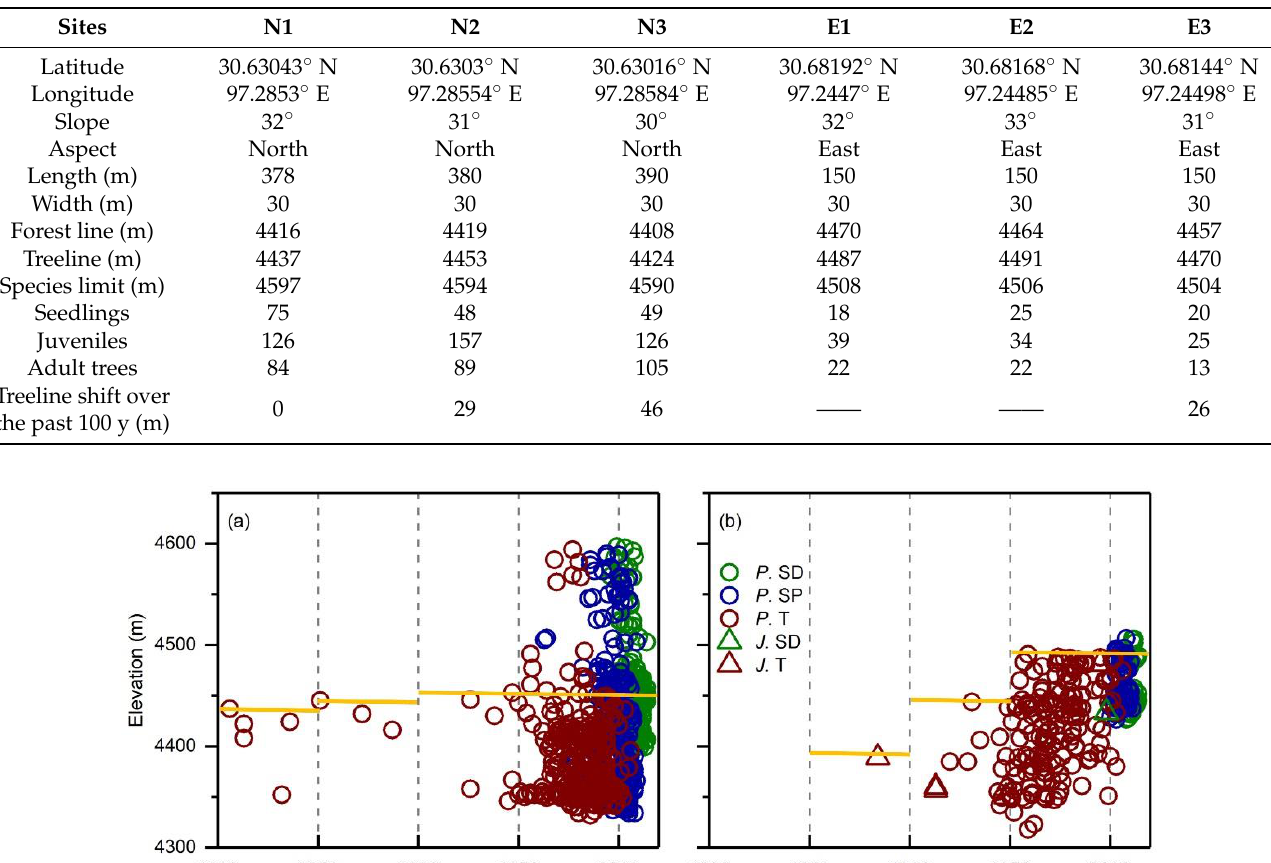
Table 1. Characteristics of the study sites.